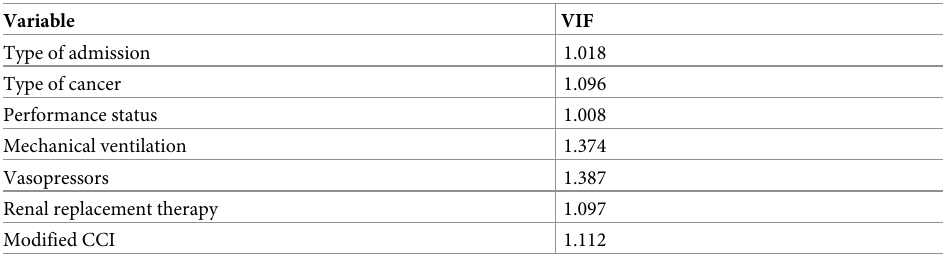
Table 3. Variation inflation index of the selected variables to be included in the logistic regression